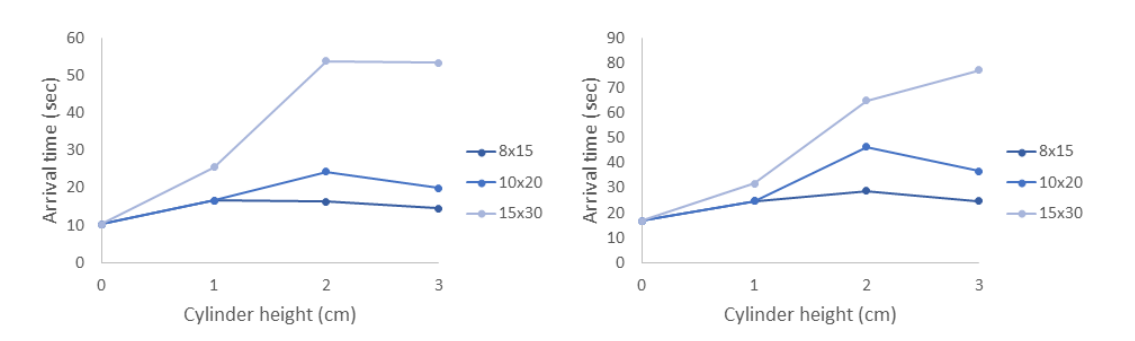
Figure 12. The average arrival time vs. cylinder height for agents in the simulations into: the green zone ( left ); and blue zone ( right